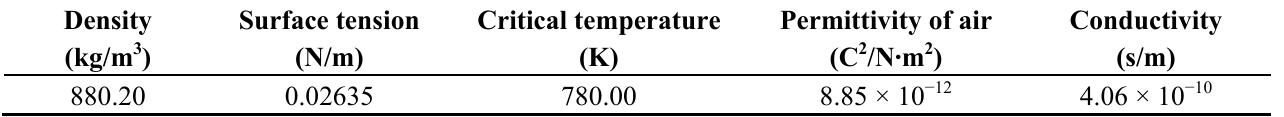
Table 1. Calculated constants and liquid properties for